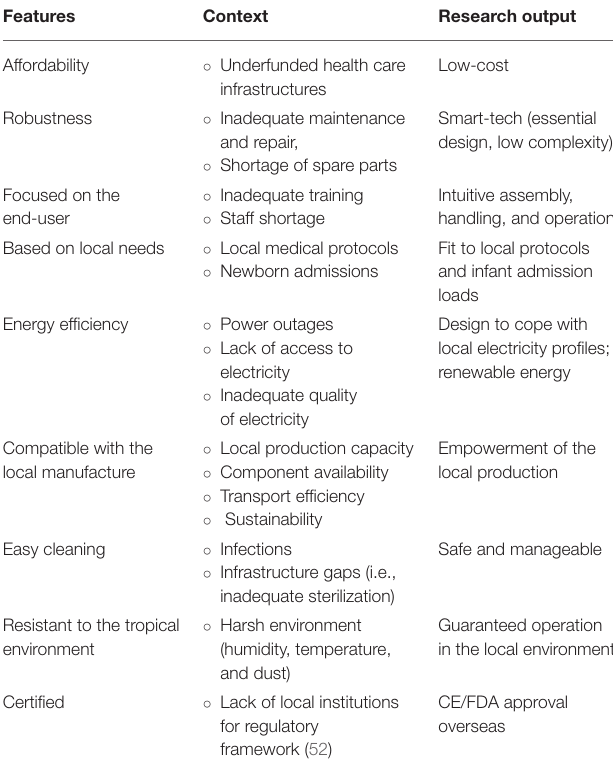
TABLE 1 | Essential features for incubators tailored to the SSA contexts, needs, and